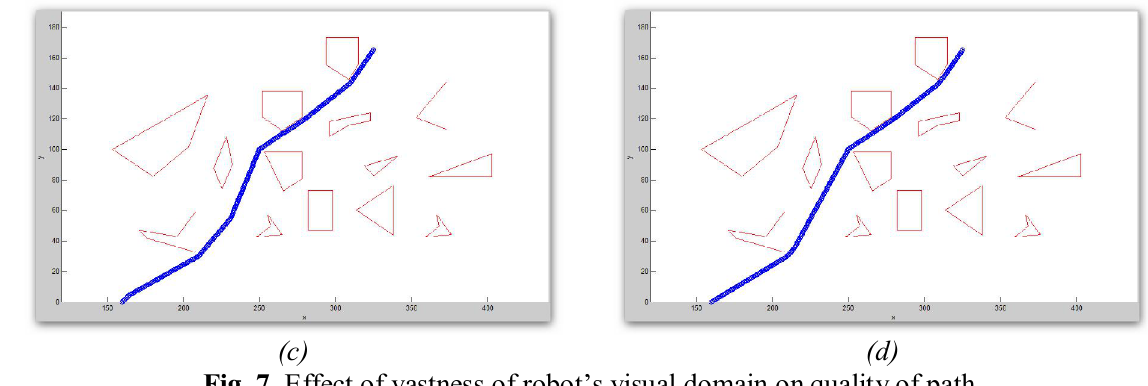
Fig. 7. Effect of vastness of robot’s visual domain on quality of